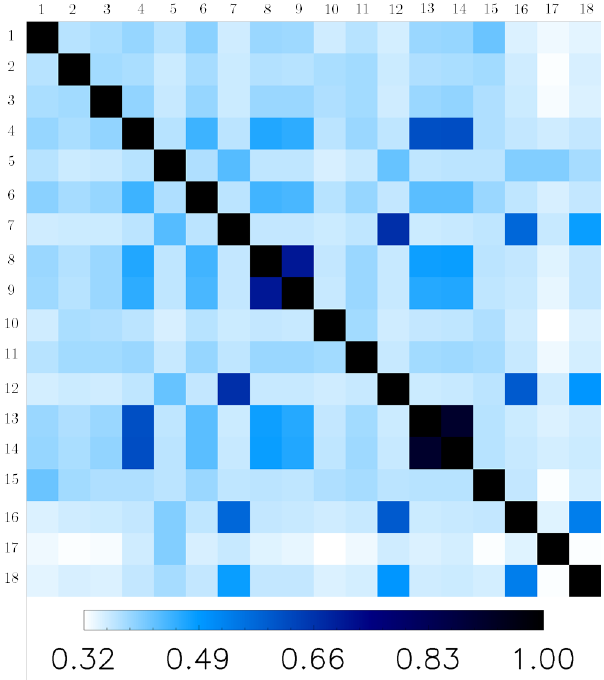
(cid:112) H ( Y 1 ) H ( Y 2 )